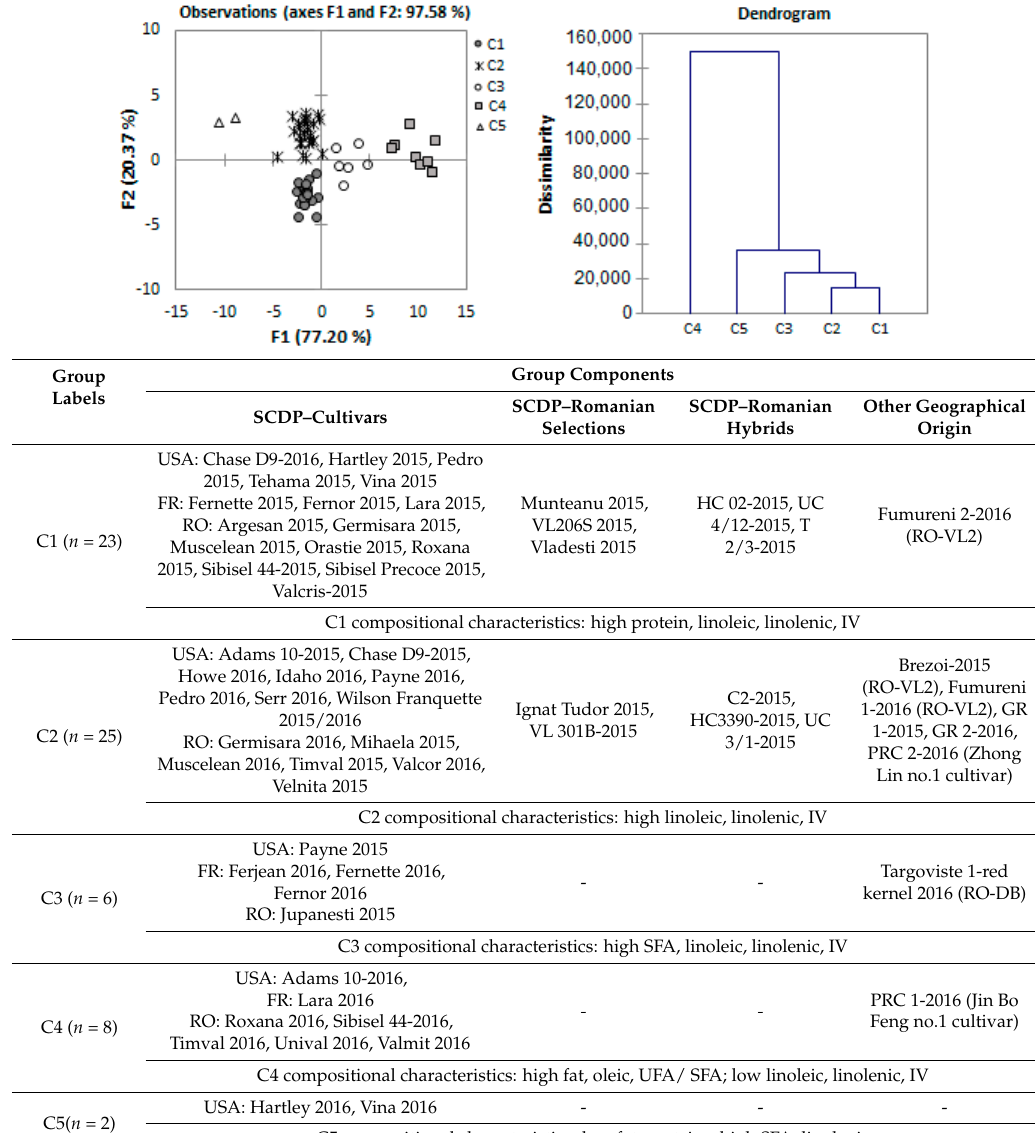
Table 3. Classification of the walnuts according to composition.